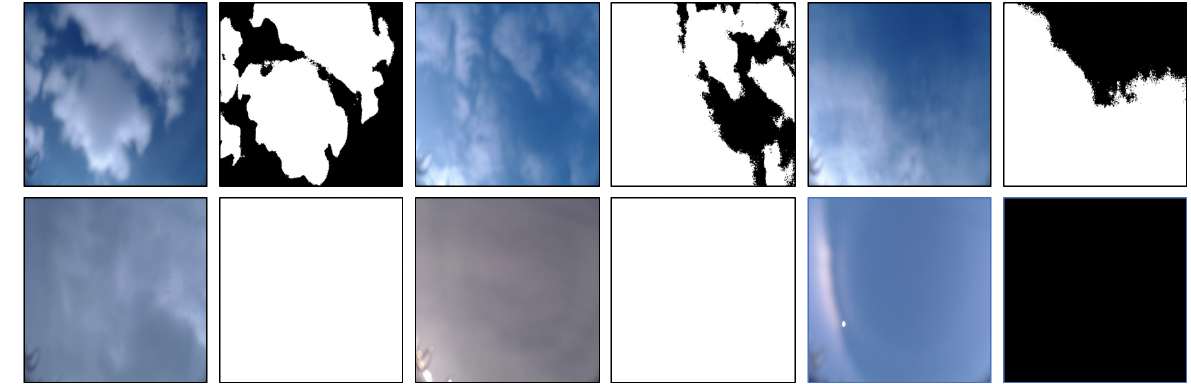
Figure 2. Example images and corresponding labels from the Waggle cloud dataset. The original image resolution was 2304 × 1536, resized to 300 × 300 to improve computational performance during the training process (see Section 2). The sky pixels were identified by the two-step process described in Section